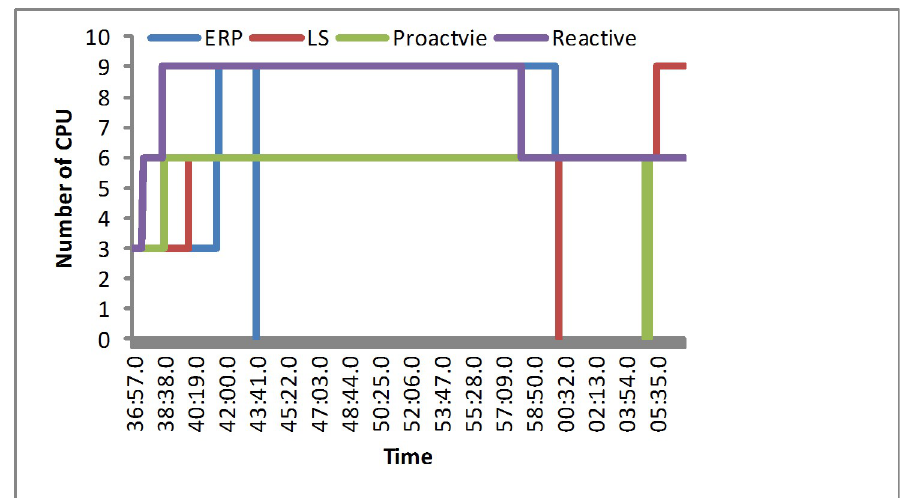
Fig 5. The number of CPUs in the synthetic load.